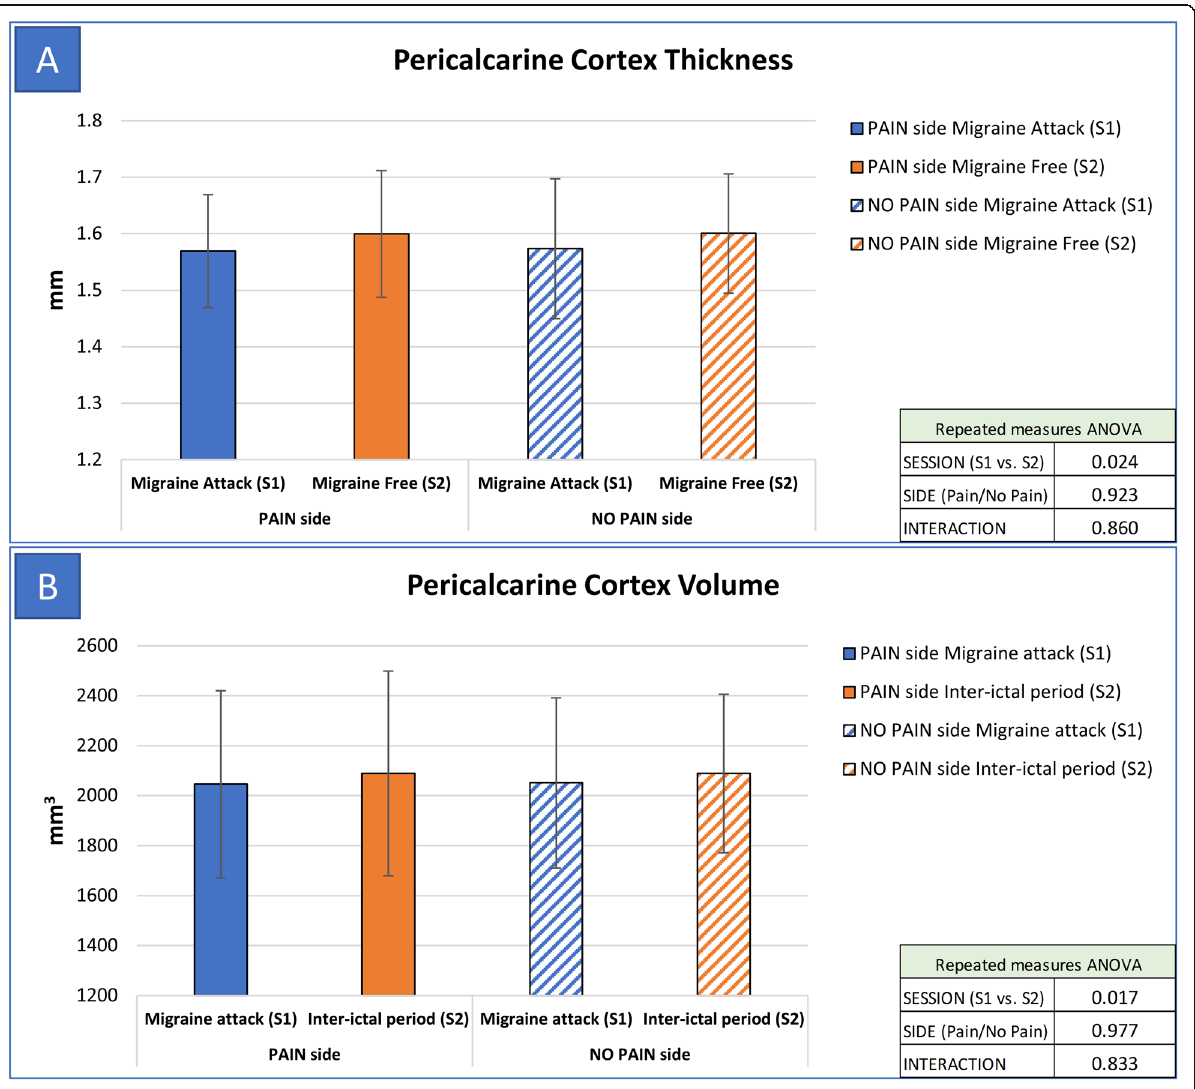
Fig. 2 Comparison of pericalcarine cortex thickness and volume between S1 and S2 scans. Legend: S1: MRI scan performed during spontaneous migraine attack; S2: MRI scan performed during inter-ictal period; PAIN side refers to the side of spontaneous migraine attack recorded at T1. Panel A: thickness of pericalcarine cortex was significantly lower during S1 (factor SESSION: p = 0.024), without significant association with the pain side (factor SIDE: p = 0.923, interaction SESSIONxSIDE: p = 0.860). Panel B: volume of pericalcarine cortex was significantly lower during S1 (factor SESSION: p = 0.017), without significant association with the pain side (factor SIDE: p = 0.977, interaction SESSIONxSIDE: p =